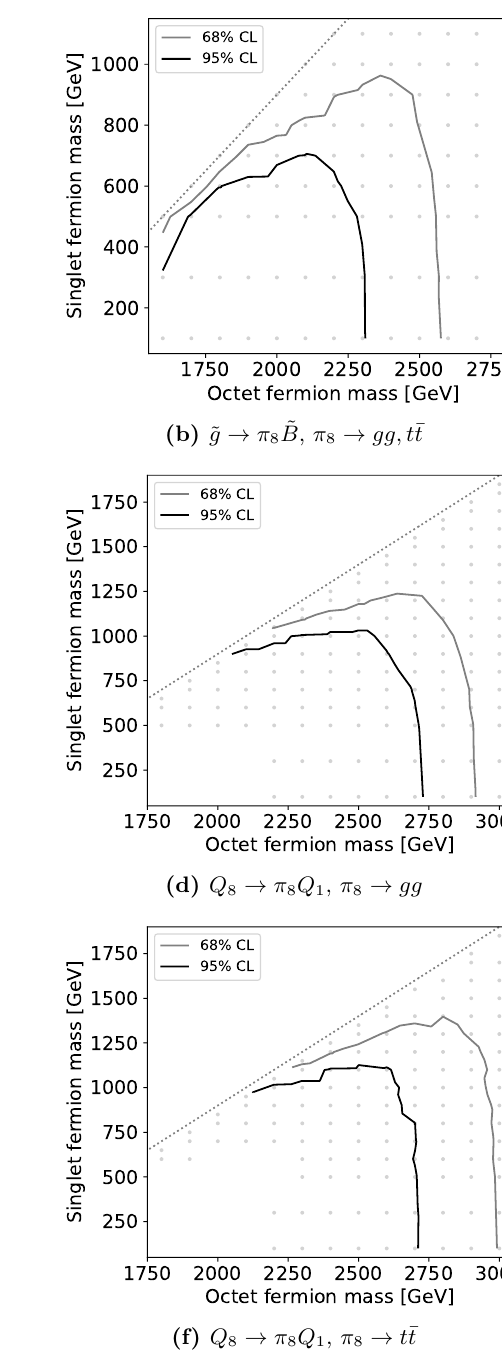
(e) Q 8 → π 8 Q 1 , π 8 → gg, t ¯ t (f) Q 8 → π 8 Q 1 , π 8 → t ¯ t Figure 7. Bounds on the fermion masses for QCD pair production of an octet fermion Q 8 with subsequent decay to a singlet fermion Q and a π . The octet pNGB mass is fixed to m = 1 . 1 TeV. 1 8 π 8 In the first row only the gluoni is considered, which decays to a π and a boni. In the second 8 row the complete multiplets are taken into account, Q = ( ˜ G + , ˜ G 0 , ˜ g ) and Q = (˜ h + , ˜ h 0 , ˜ B ) . The 8 1 multiplets are assumed to be almost mass degenerate. The boni is stable, for the π we consider 8 the decays to gg (left column), to t ¯ t (right column) or to either with equal branching ratio of 50% (middle